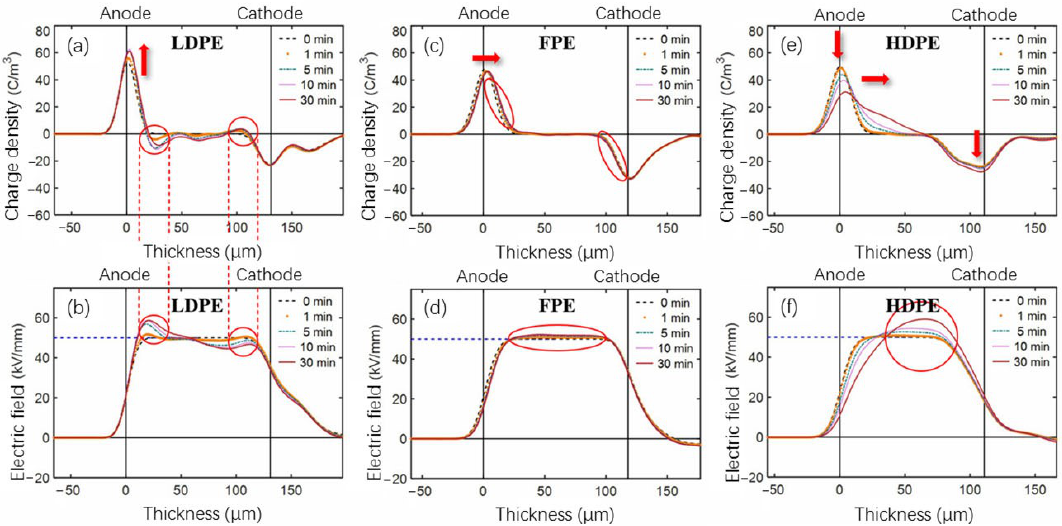
Figure 13. ( a , c , e ) Space charge and ( b , d , f ) electric field distribution of single-layer unaged LDPE, FPE, and HDPE samples polarized for 30 min under − 50 kV/mm,